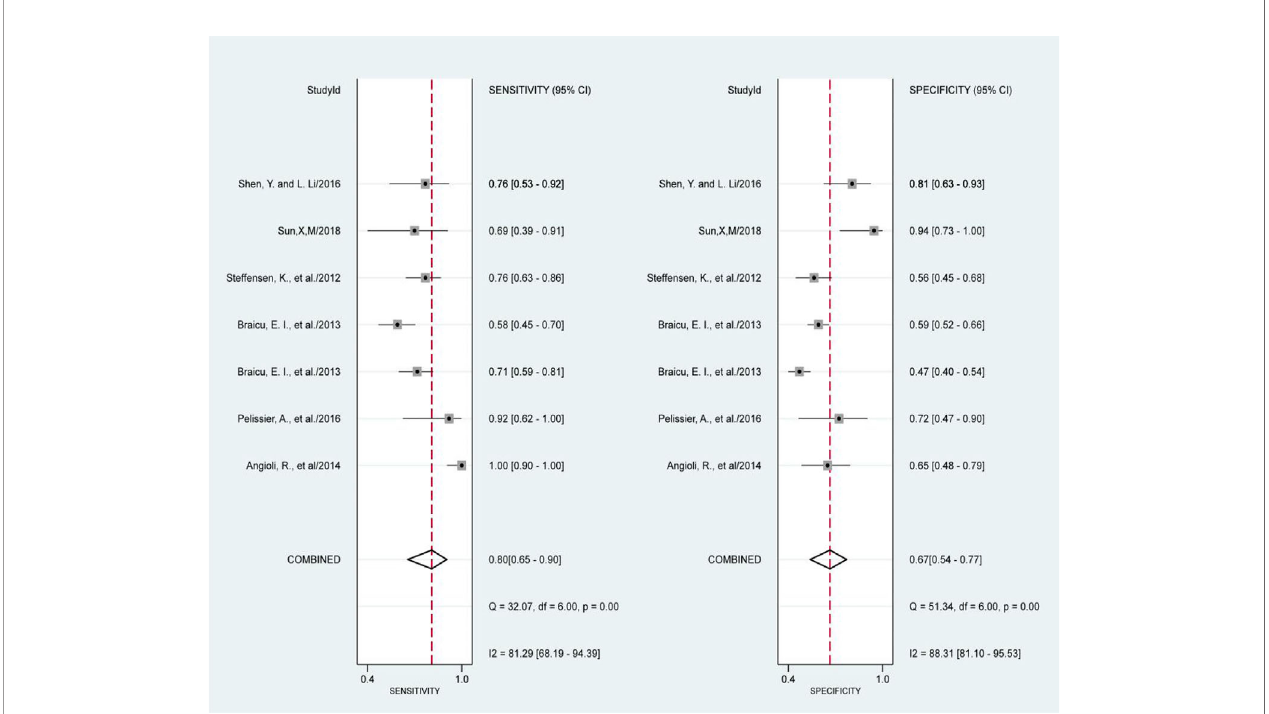
FIGURE 4 | Forest Plots of paired sensitivity and speci fi city for HE4 after third